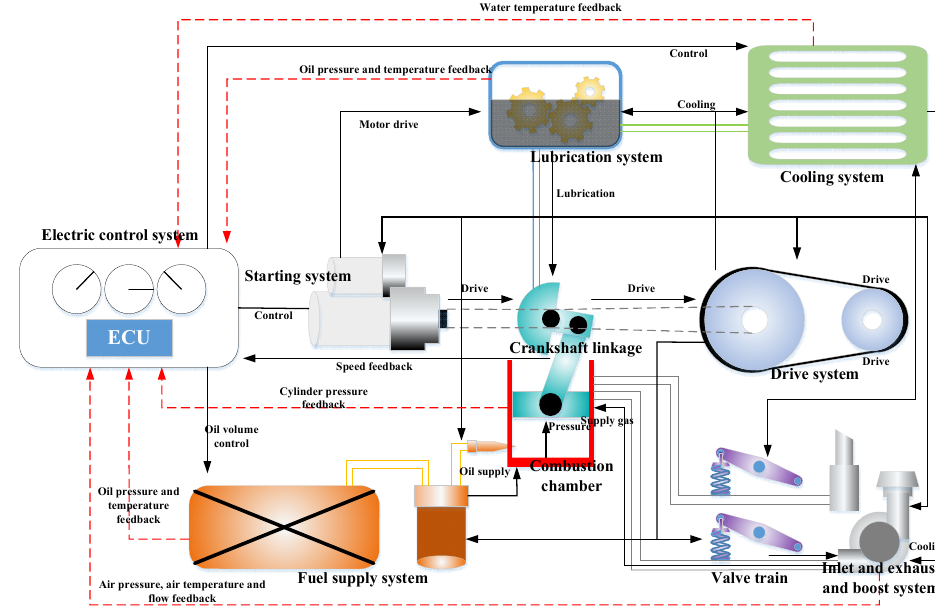
Figure 10. A schematic diagram of the diesel engine composition system.